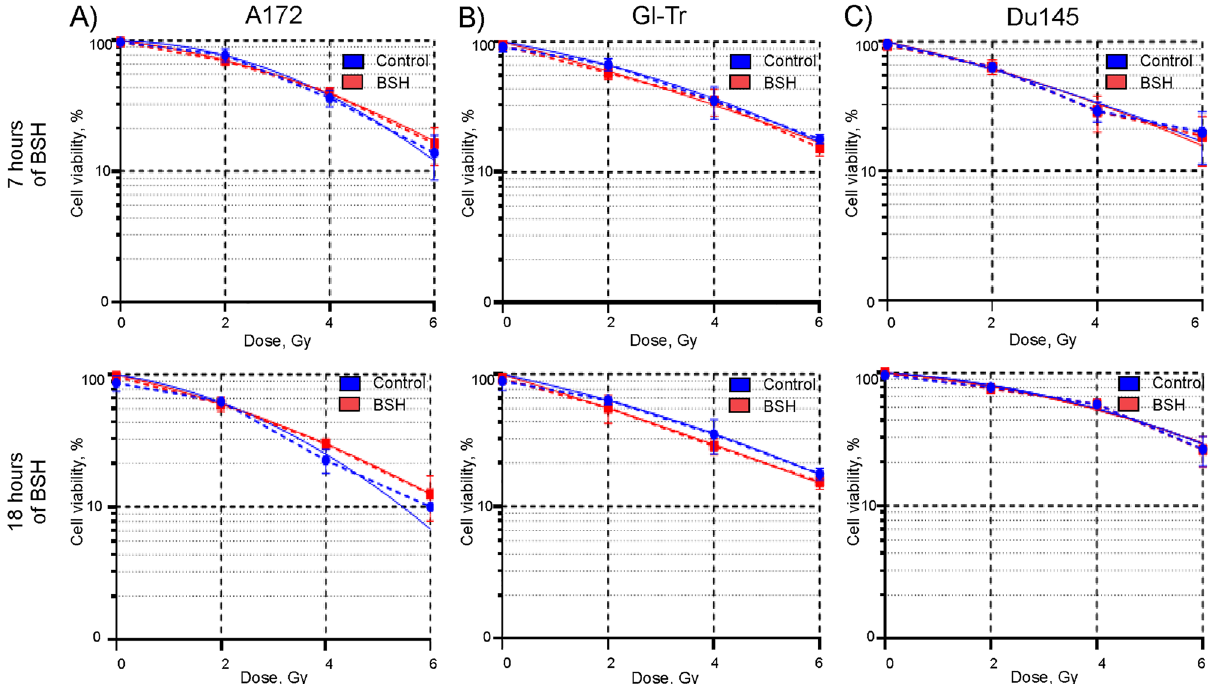
Figure 3. Effect of BSH on cell viability after exposure to Bragg peak protons at different absorbed dose. Summary plots for AlamarBlue cell viability assays: ( A ) A172 cells, ( B ) Gl-Tr cells, ( C ) DU145 cells (dashed lines). The cells were incubated in a medium containing 80 ppm of boron-11 for 7 h (up panels) or 18 h (bottom panels) and then irradiated by 89.7 MeV clinical proton beam in a dose range of 0–6 Gy. Data were fitted with a linear-quadratic function of the radiation dose (solid lines). Each plot summarizes the results of three independent irradiation experiments. α β IC 50 ,